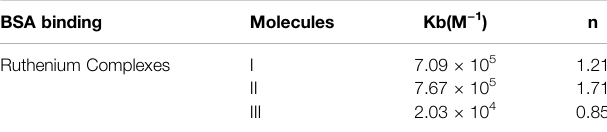
TABLE 6 | K b and n values after the treatment of Ru Complexes (I, II, and III) with BSA. BSA